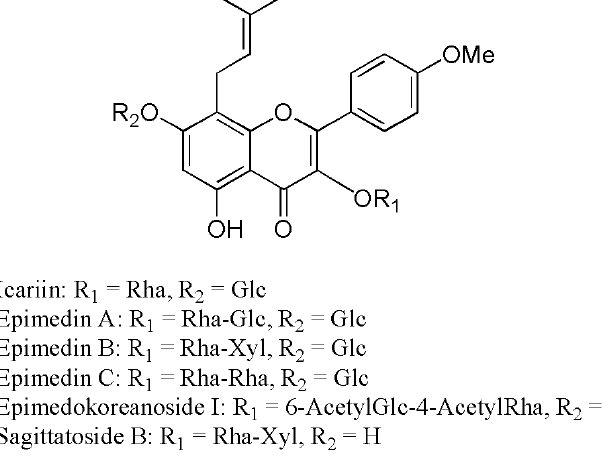
Figure 1. Molecular structures of the major prenylflavonoids isolated from Epimedii Herba.